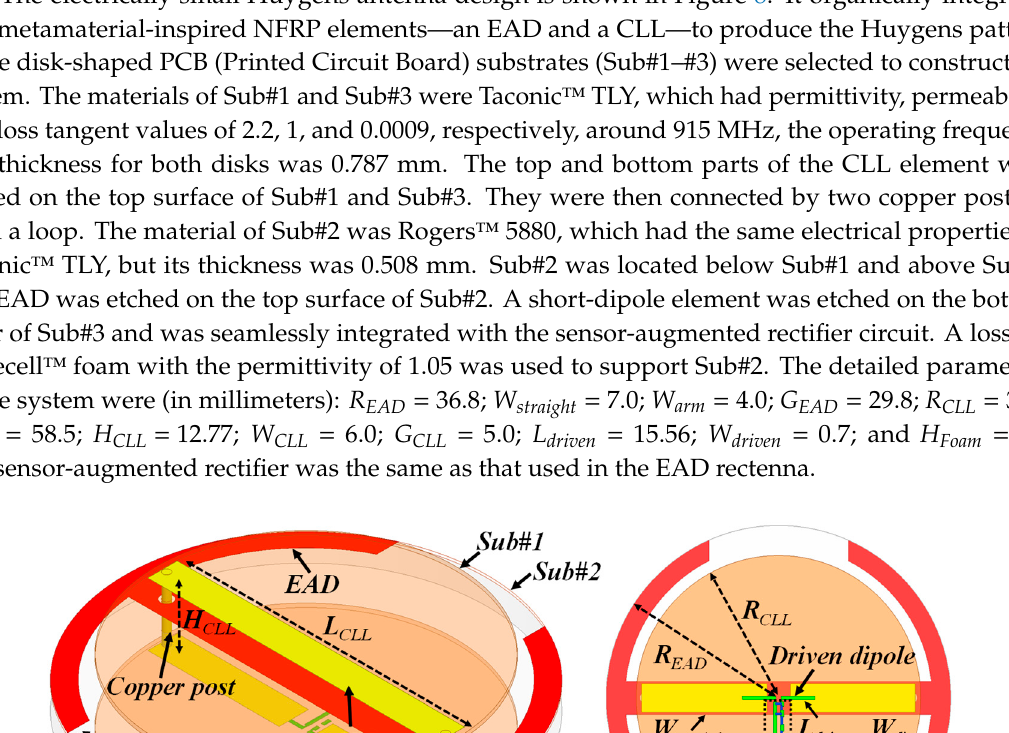
( b ) Figure 9. Simulated performance characteristics of the Huygens receiving antenna: ( a ) input impedance and ( b ) rain pattern. 900 905 910 915 920 925 930-100-50050100150200250300 350